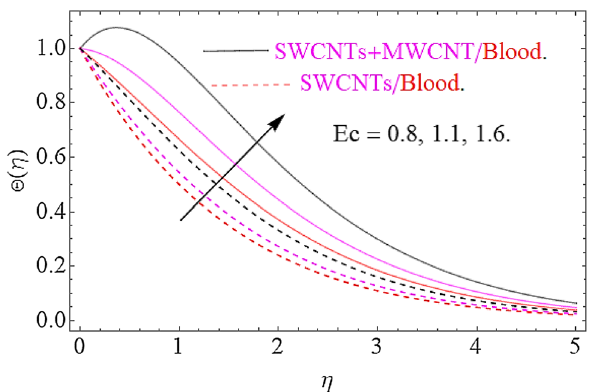
Figure 9. Impact of Ec on �(η) .